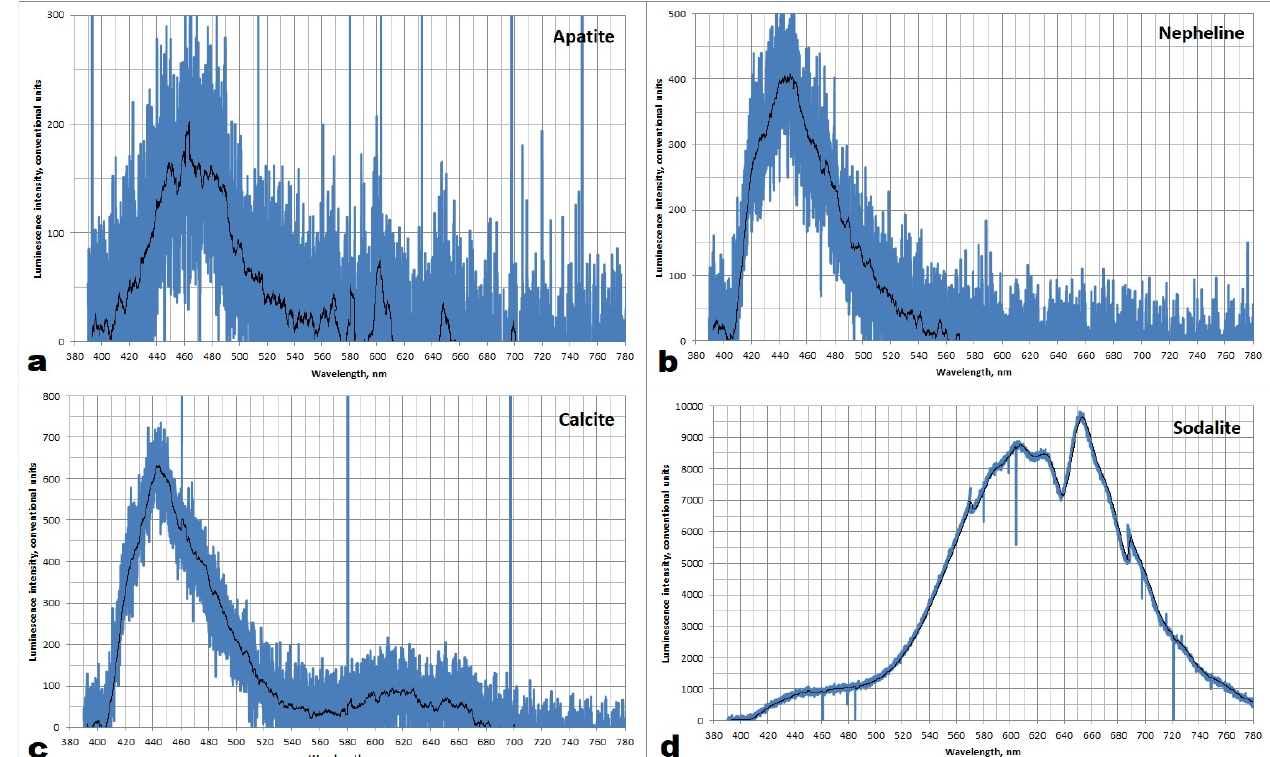
Minerals 2023 , 13 , x FOR PEER REVIEW Figure 5. Luminescence spectra of ( a ) fluorapatite; ( b ) nepheline; ( c ) calcite; ( d ) sodalite. The studied fluorapatite sample demonstrates the maximum intensity in the blue area (448, 464, 471 nm). In the yellow, orange, and red areas, narrow bands with maxima at 568 nm and 581 nm, 602 nm and 608 nm, 648 nm, respectively, are fixed. Maximums in the analyzed spectral range (380 to 800 nm) of nepheline are observed in the blue area (448, 464, 473 nm). For calcite, the maximum luminescence intensity is registered in the blue area (455, 465 nm); a wide band is fixed in the green and yellow areas of the spectral range. Maximum values of sodalite luminescence intensity are observed in orange (605, 610 nm) and red areas (655, 690 nm). Visual assessment of the studied mono-mineral fractions luminescence (Figure 6) confirms the presence of color differences: fluorapatite has pink-violet luminescence, nepheline—blue-green luminescence; calcite—pink-red luminescence; and sodalite pos- sesses orange-yellow luminescence.